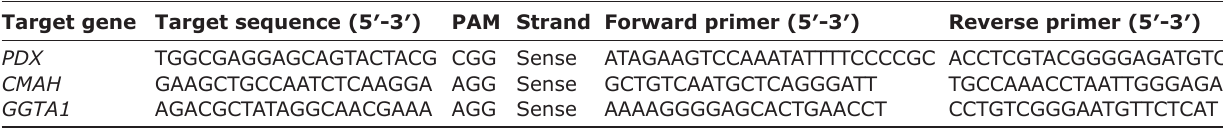
Table-1: gRNA and primer sequences targeting three genes. Target gene Target sequence